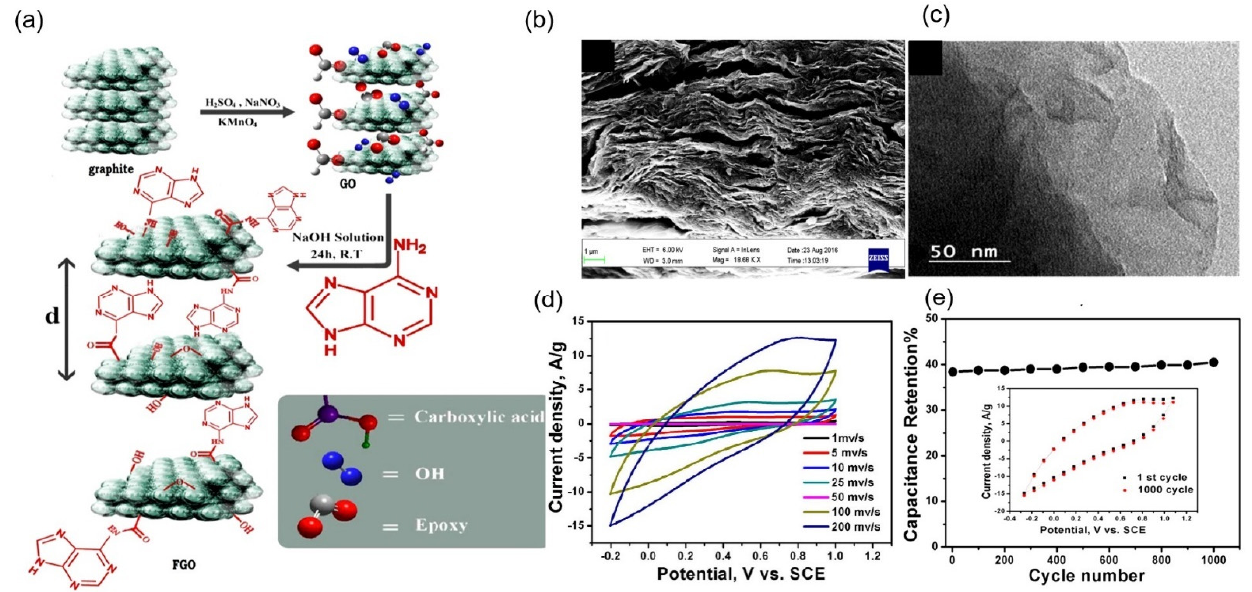
Figure 6. ( a ) Synthesis of GO and adenine-functionalized graphene. ( b ) SEM and ( c ) TEM images of FG. ( d ) The CV of FG electrodes at different scan rates in 0.5 M H 2 SO 4 . ( e ) The first and 1000th CV cycles of the FG electrodes. Reprinted from [65]. Copyright (2017), with permission from Springer Nature.